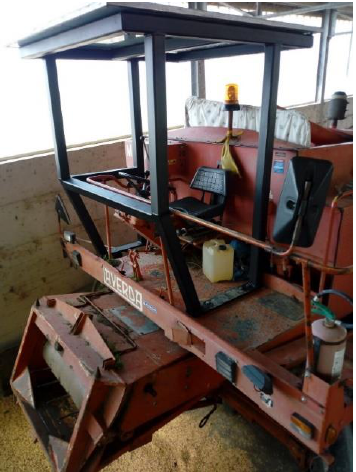
Figure 15. Physical model of TOPS retrofitted on the combine harvester.